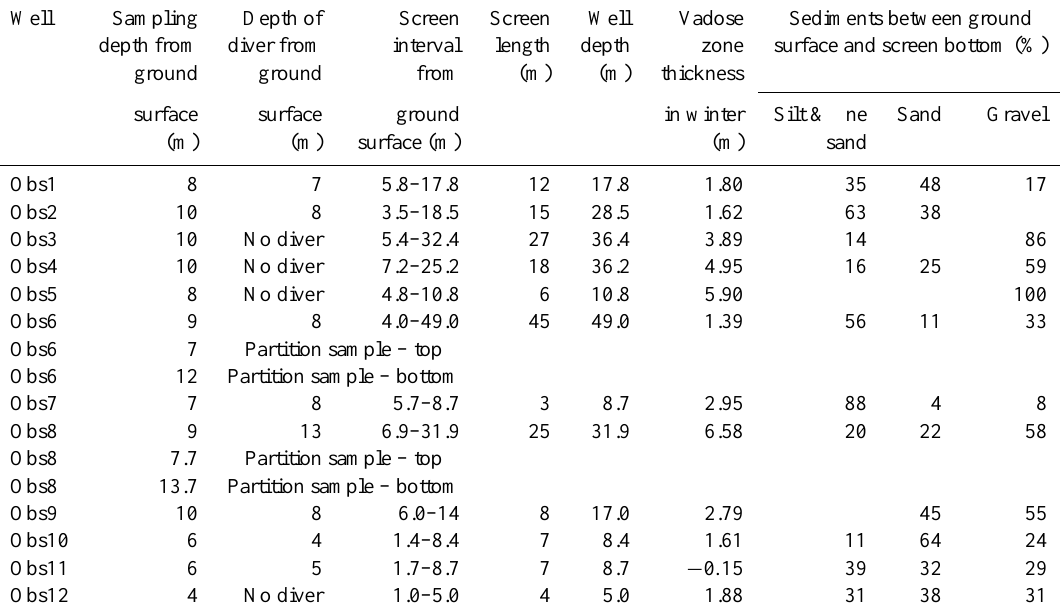
Table 1. Observation well information of the sampling depth, screen depth, and vadose zone thickness during the sampling periods. The negative vadose zone thickness means that the well was flooded during the